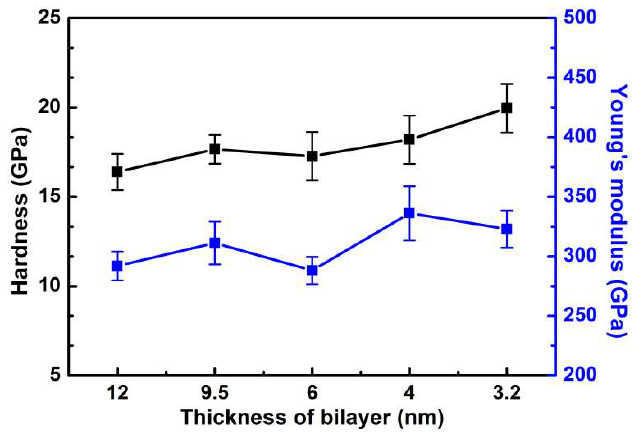
Figure 5. Hardness and Young’s modulus values of CrN / CrAlSiN coatings with bi-layers of various thicknesses.